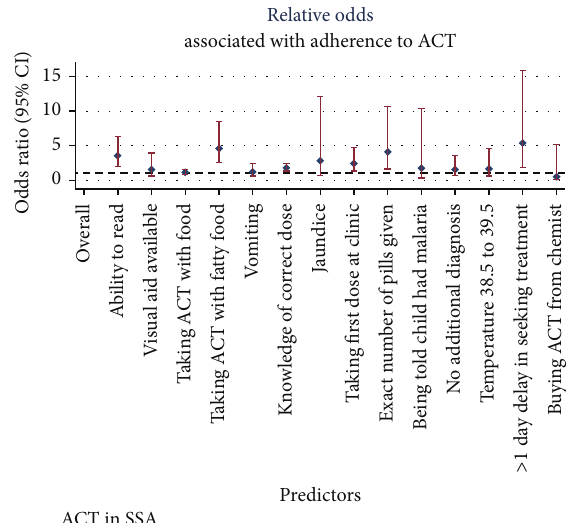
Figure 5: Clinical and dispensing-related predictors of ACT adher-